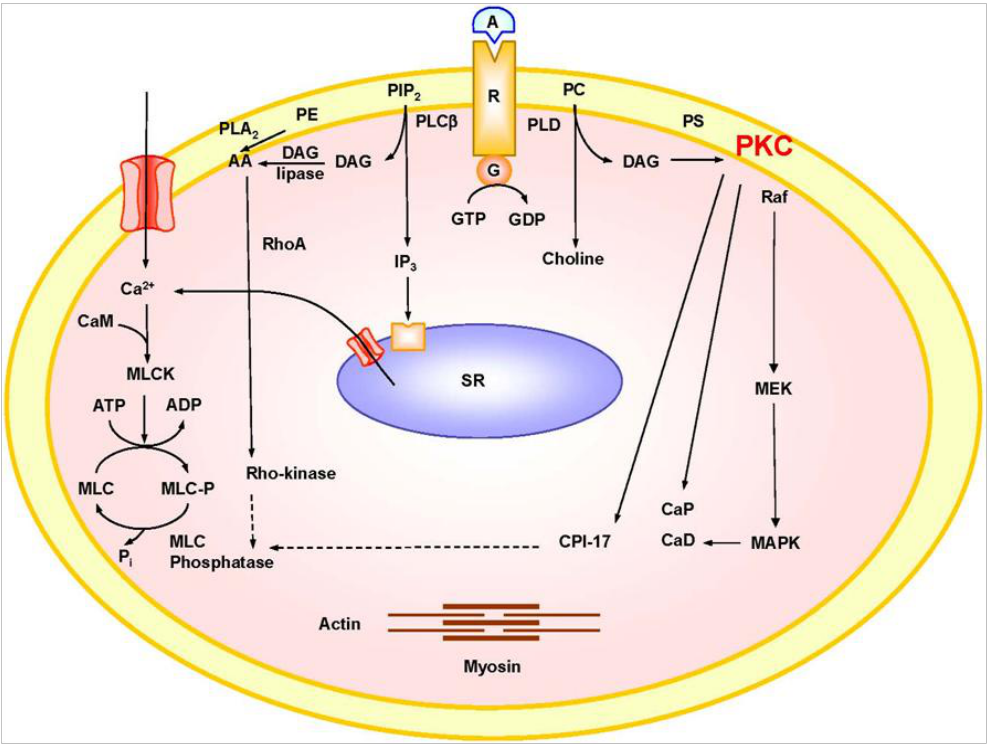
Figure 1. Mechanisms of VSM contraction. The interaction of an agonist (A) such as phenylephrine with its specific  -adrenergic receptor (R) activates phospholipase C (PLCβ) and stimulates the hydrolysis of phosphatidylinositol 4,5-bisphosphate (PIP ) into 2 inositol-1,4,5-trisphosphate (IP ) and diacylglycerol (DAG). IP stimulates Ca 2+ release 3 3 from the sarcoplasmic reticulum (SR). Agonists also stimulate Ca 2+ influx through Ca 2+ channels. Ca 2+ binds calmodulin (CAM), activates MLC kinase (MLCK), causes MLC phosphorylation, and initiates VSM contraction. DAG activates PKC. PKC-induced phosphorylation of CPI-17, inhibits MLC phosphatase and increases MLC phosphorylation and VSM contraction. PKC-induced phosphorylation of the actin-binding protein calponin (CaP) allows more actin to bind myosin and enhances contraction. PKC may also activate a protein kinase cascade involving Raf, MAPK kinase (MEK) and MAPK, leading to phosphorylation of the actin-binding protein caldesmon (CaD) and enhanced contraction. Activation of RhoA/Rho-kinase inhibits MLC phosphatase and further enhances the Ca 2+ sensitivity of contractile proteins. AA, arachidonic acid; G, heterotrimeric GTP-binding protein; PC, phosphatidylcholine; PE, phosphatidylethanolamine; PLD, phopholipase D; PS, phosphatidylserine. Dashed line indicates